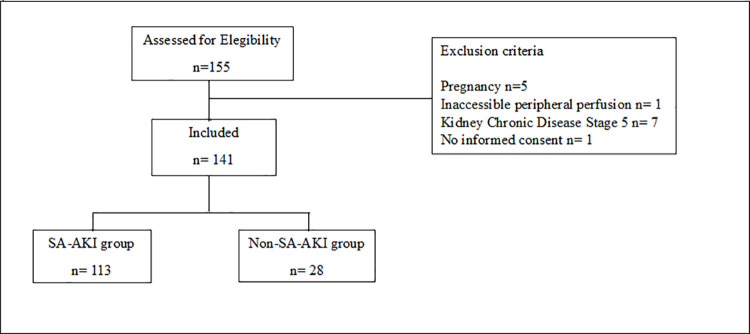
Flow-chard of study.